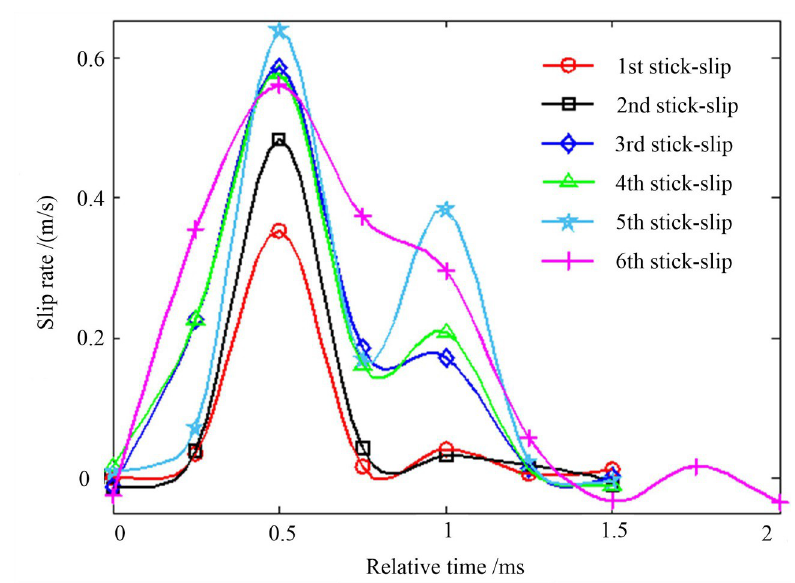
Fig 8. The evolution curve of the slip rate during the fault stick-slip